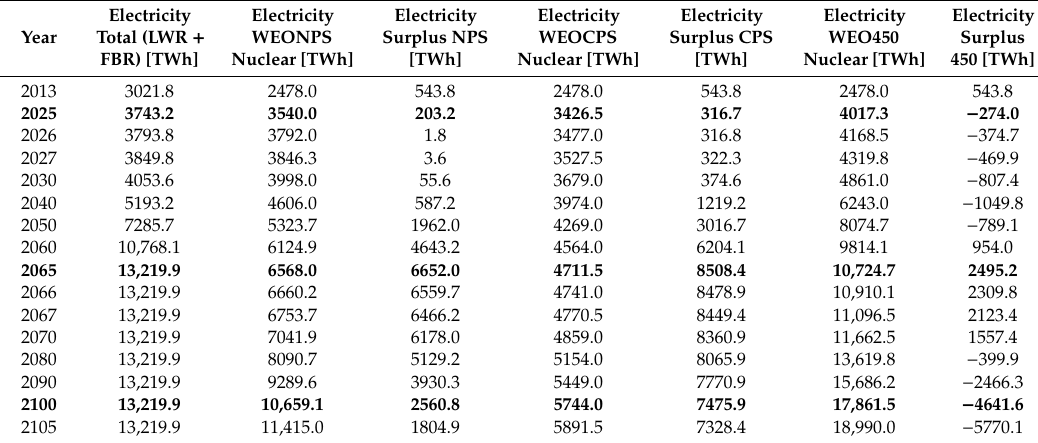
Table 4. Electricity surplus for scenario S1, sub scenario A.